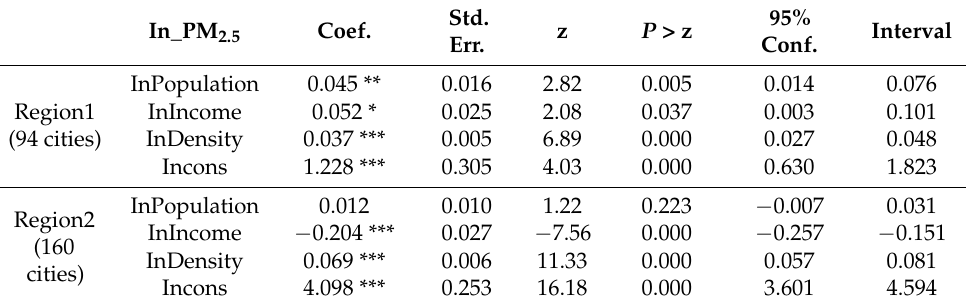
Table 8. Threshold regression of PM 2.5 concentrations for 254 cities by population size. Std. In_PM 2.5 Coef. Err.